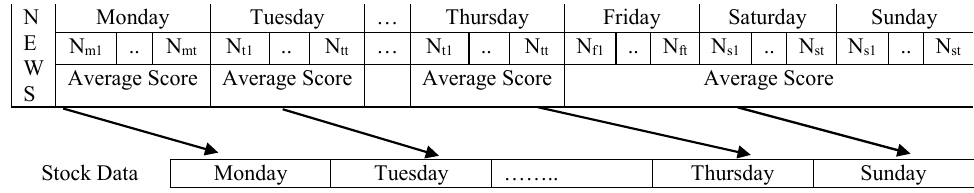
Figure 2. Mapping between financial news sentiment scores and stock data.